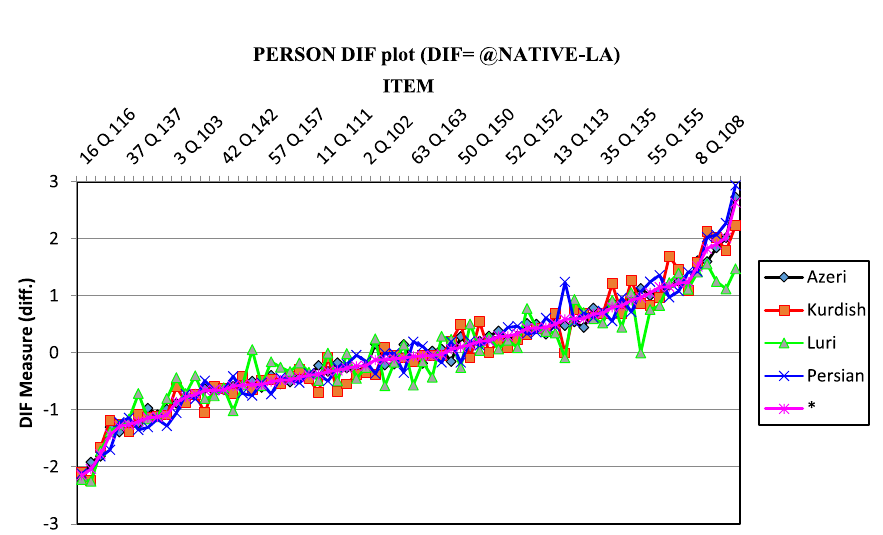
Fig. 2 Uniform differential item functioning in the Iranian Undergraduate University Entrance Special English IUUESEE